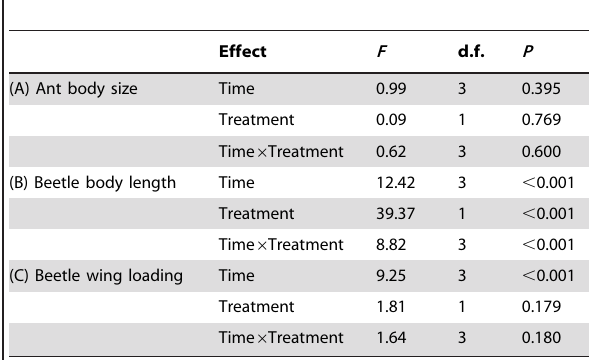
Table 3. Effects of carcass treatment, time, and their interaction on insect morphological